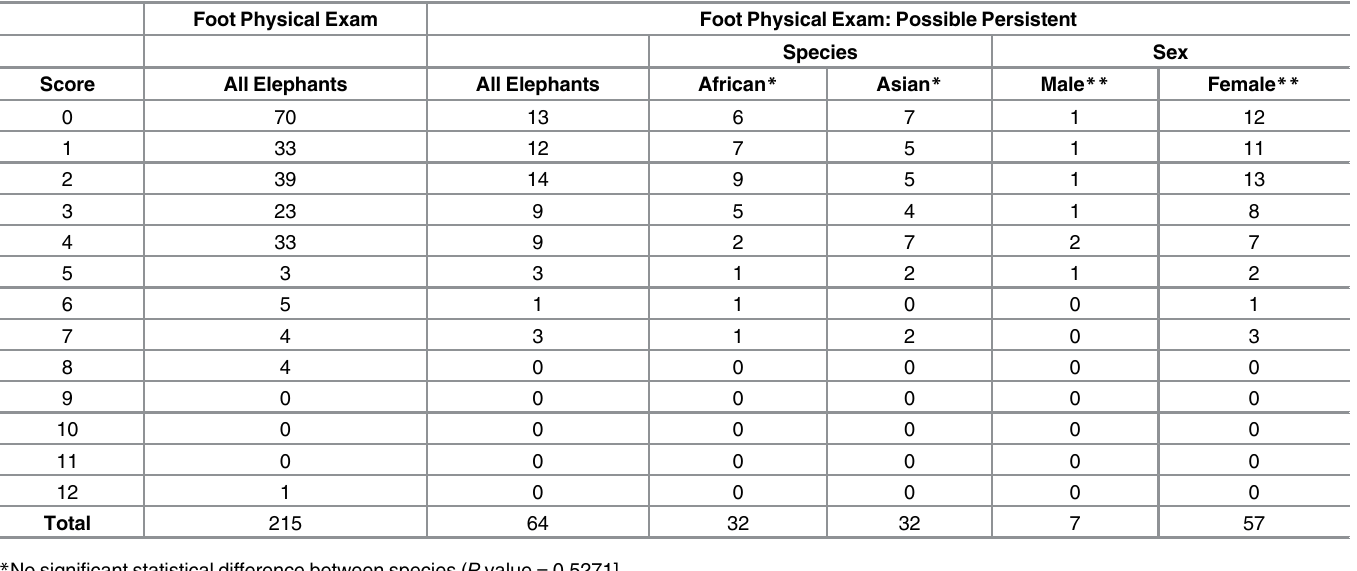
Table 6. Frequency of elephants per foot score for the Foot Physical Exam and for Possible Persistent Foot (PPF) scores. The Foot Physical Exam was conducted in 2012. Possible Persistent Foot (PPF) scores were defined by an elephant ’ s 2012 physical exam score only for elephants that had existing 2011 veterinary records showing foot abnormalities in